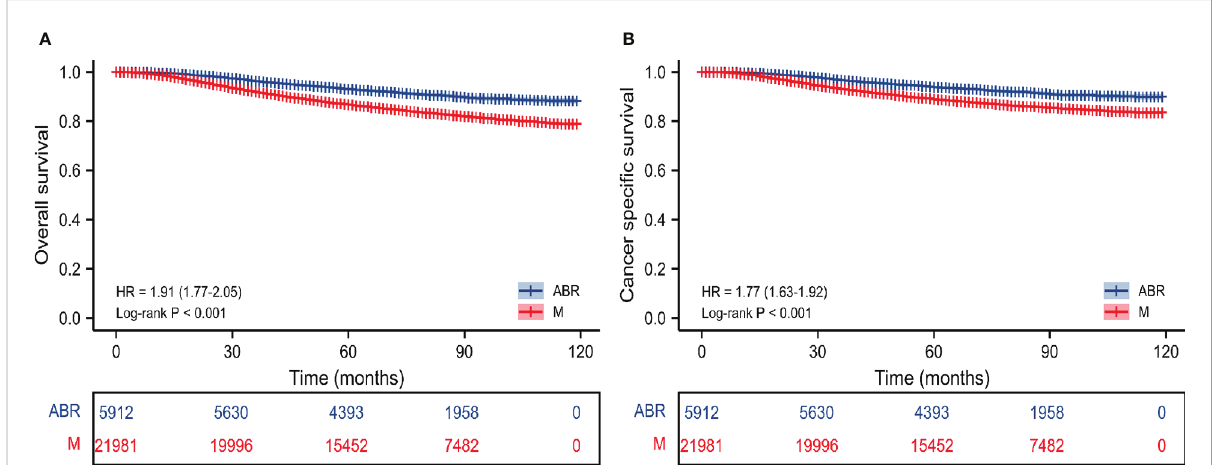
FIGURE 1 Kaplan-Meier survival curves of survival analysis on OS (A) and CSS (B) before PSM in the entire cohort. M, mastectomy; ABR, autologous breast reconstruction; OS, overall survival; CSS, cancer speci fi c survival.